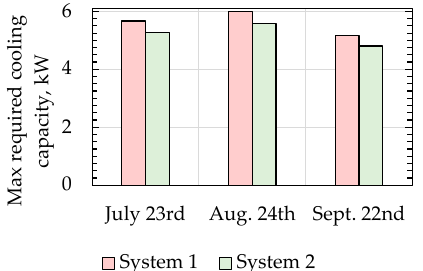
Figure 8. Maximum required cooling capacities for System 1 and System 2 during the cooling season.